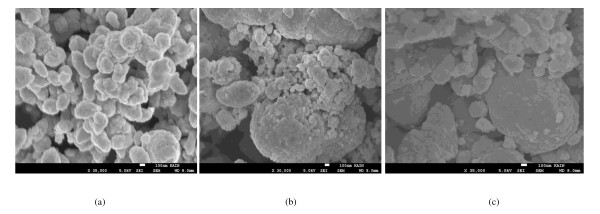
SEM micrographs of (a) 0.0, (b) 0.5, and (c) 0.1 compositions of Ni0.7-xZnxCu0.3Fe2O4 ferrite nanoparticles.